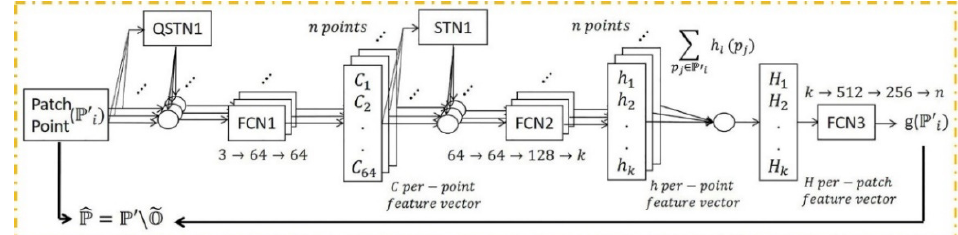
Figure 8. PointCleanNet outlier removal architecture; ℙ′ , ℙ(cid:3553) , and 𝕆(cid:3561) denote a dataset contaminated with outliers as input, the dataset after outlier removal, and outliers, respectively. FCN and (Q)STN are the Fully Connected and (Quaternion) Spatial Transformer Networks. The input is a patch point, and output is a label for each point related to its status as an outlier [22].